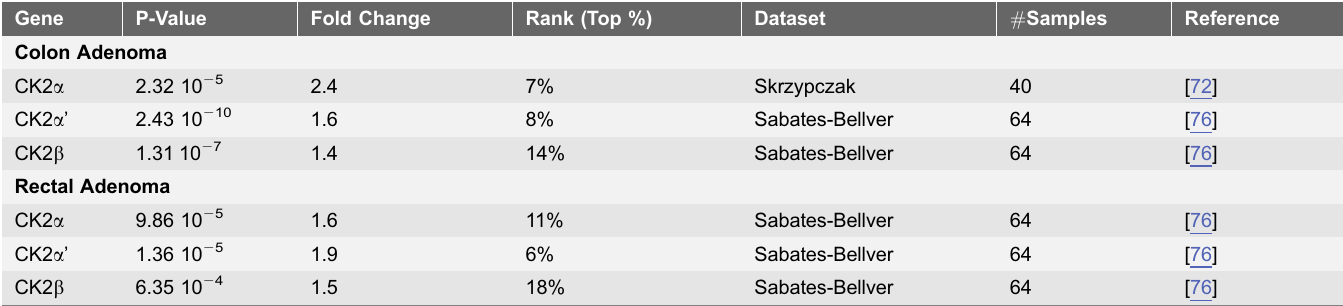
Table 4. Changes in CK2 gene expression in non-neoplastic colon